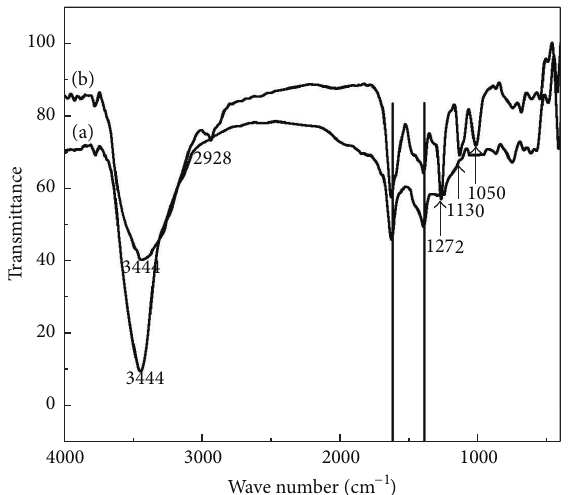
Figure3:FTIRspectra(a)passivatedpowdersand(b)insulatediron powders at pH